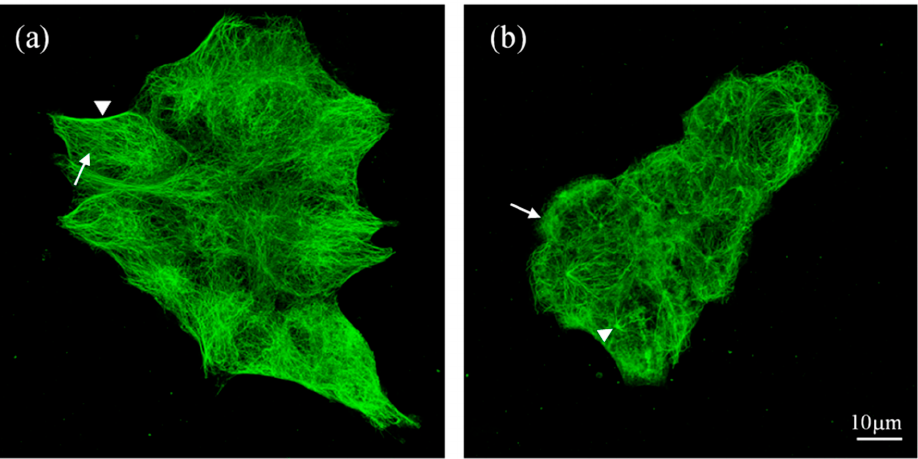
Figure 4. Microtubular networks in the control and 1d -treated HTC116 cells visualized by staining with anti- α -tubulin 12g10 Ab. ( a ) Control cells—arrow: MTs arranged along the long cell axis; arrowhead: MTs lining the cell border. ( b ) Cells treated with compound 1d —arrow: amorphous material; arrowhead: center of microtubule organization with the arising microtubules.